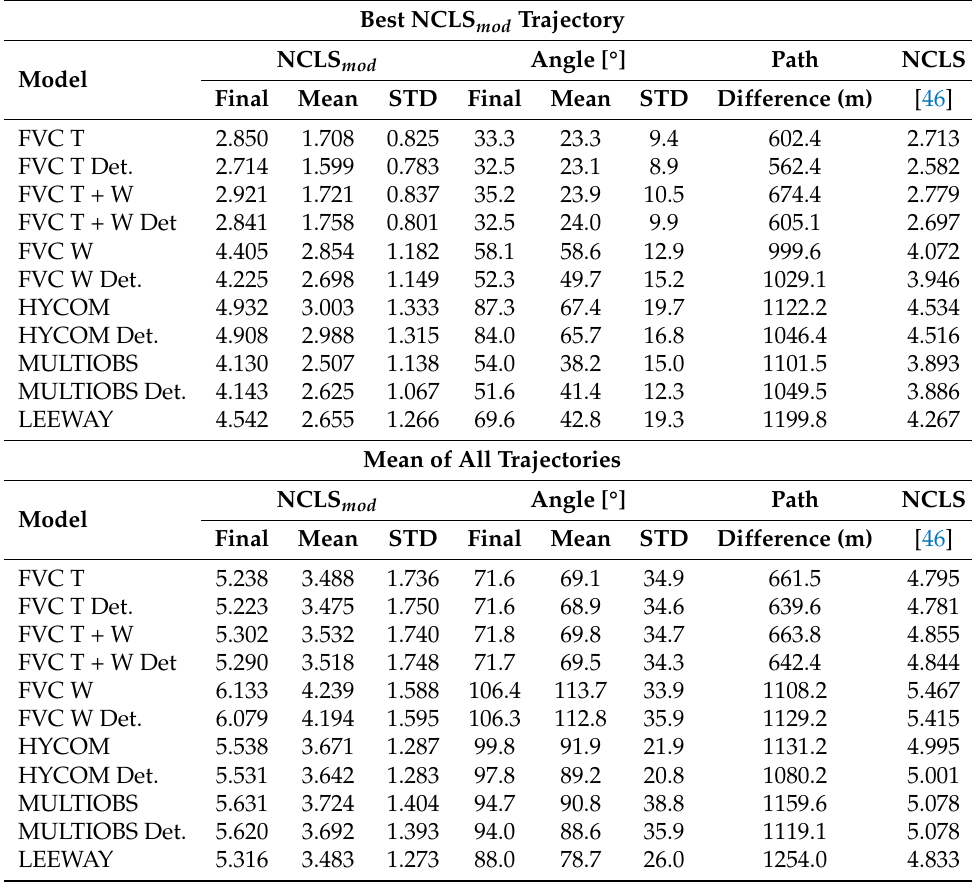
Table A1. Performance statistic values for each model and scenario used for 10 September